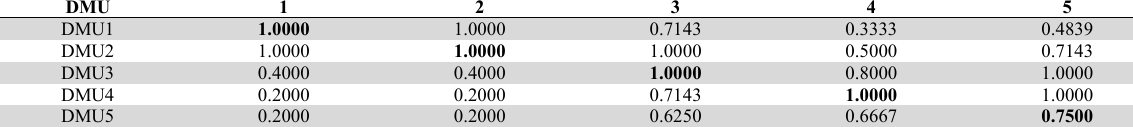
RCA cross-efficiency matrix (RCA-CEM) of performance assessment problem DMU 1